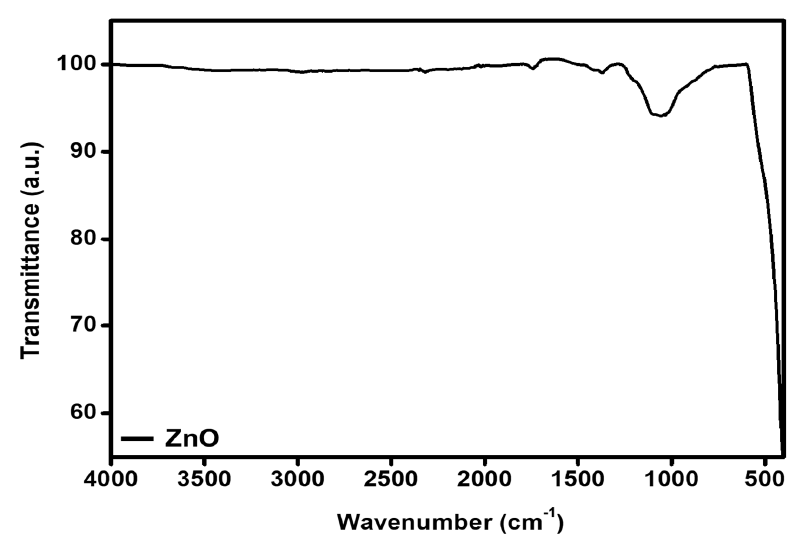
Figure 3. FT-IR spectrum of as-synthesized ZnO-GS NPs. The SEM images of varying magnifications are given in Figure 4. The images ob- tained of the as-synthesized ZnO-GS NPs reveal a porous surface with irregular morphol- ogy. The elemental composition of the prepared ZnO-GS nanoparticles is estimated using EDX spectroscopy and the percentage data obtained are given in Figure 5. It reveals that the synthesized heterostructure contains the desired elemental composition, i.e., Zn and O, and the percentage of elemental compositions are shown in the inset table. Figure 4. SEM images of the as-synthesized ZnO-GS NPs.